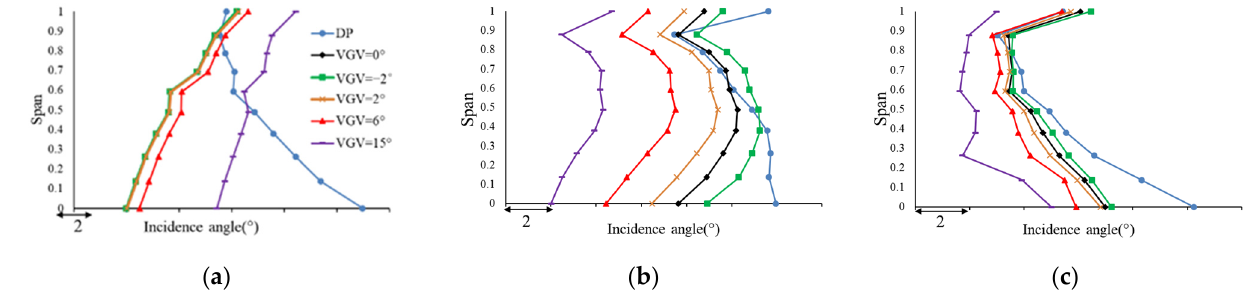
Figure 17. Incidence variation (VGV1 adjustment). ( a ) R1; ( b ) S1; ( c ) R2.